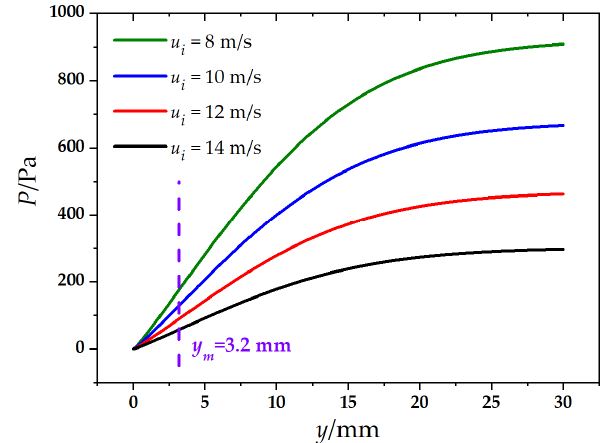
Figure 9. Relation between pressure and y -axis under four different u i .